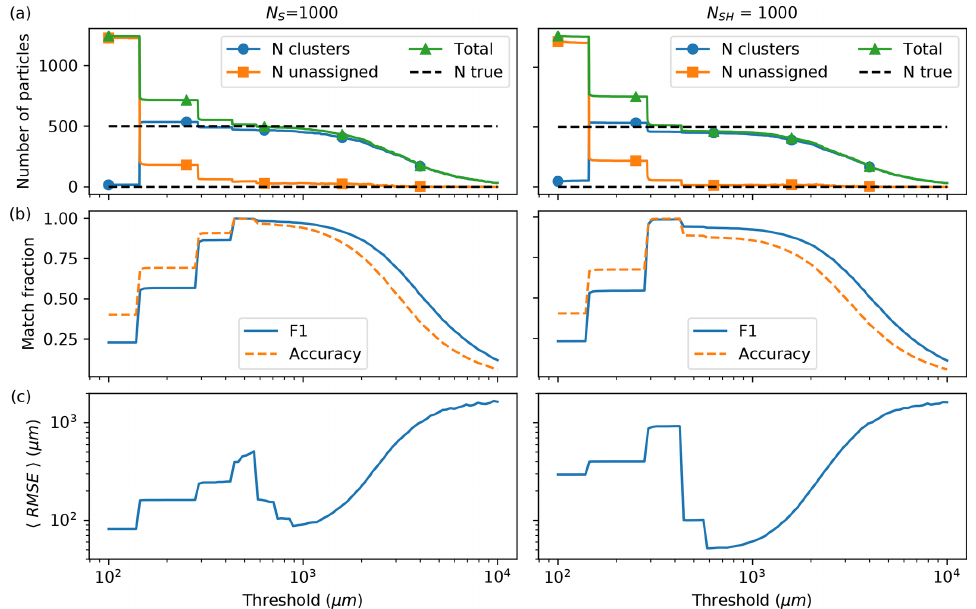
Figure 6. In (a) – (c) , the number of particles, the matched F1 and accuracy metrics, and the average RMSE, computed for predicted particles paired with true particles, are all shown versus the match distance threshold, respectively. The left and right columns show the results for the noise-free N S = 1000 model and the noise-optimized N SH = 1000 model, respectively. In (a) , the horizontal grid lines denote 0 and 500 particles.